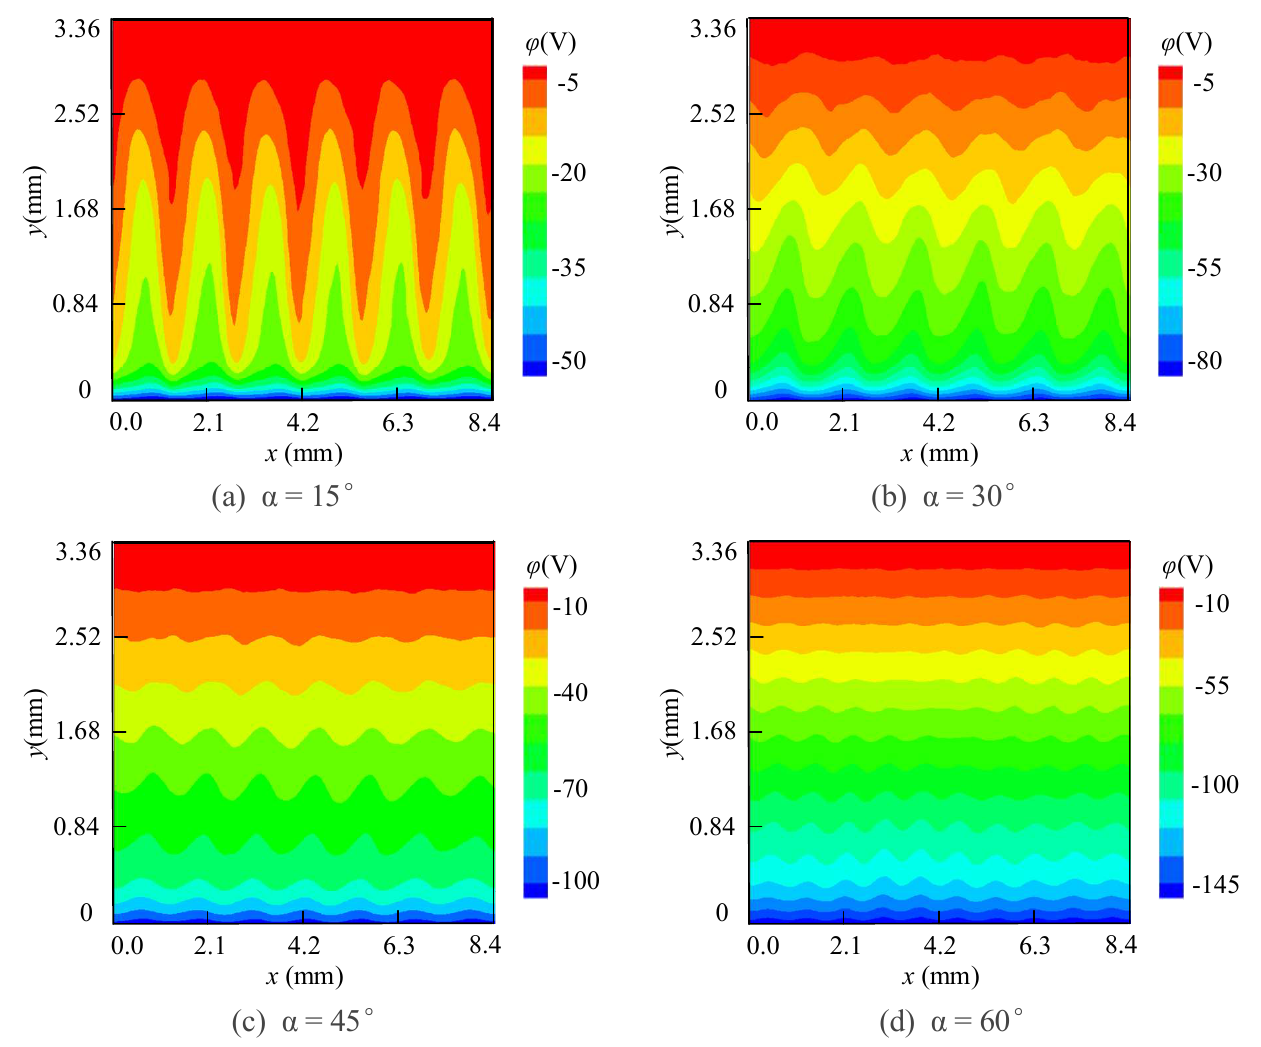
Figure 7. The 2D spatial distributions of electric potential with different values of the positive α. The behavior of electrons could be the explanation for the above phenomenon. The periodic distribution of the potential driven by ECDI leads to an electric field (cid:101) E x along the azimuthal direction, as shown in Figure 5. The average value of (cid:101) E x is non-zero and positive. When the magnetic field component B z is applied in the axial direction, a new orthogonal field (cid:101) E x × B z will be generated. The new orthogonal field induces a new drifting motion perpendicular to the wall surface. If the value of α is positive, the new drifting motion of the electrons is towards the wall. This movement increases the velocity of the electrons tending to the wall. Therefore, the electron flux that can reach the wall becomes larger, and the potential drop in the sheath increases. As the value of the positive α increases, the radial drift velocity increases. More electrons can reach the wall and make the wall potential decreases. Therefore, it can be seen from the electron density distribution shown in Figure 8 that as the value of positive α increases, the wall potential decreases and the low-density region of the electrons near the wall